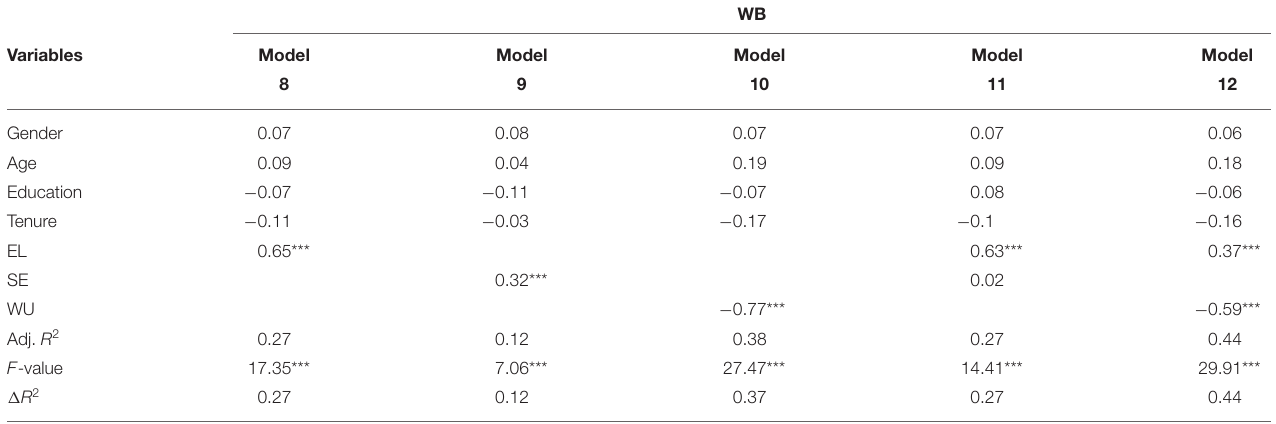
TABLE 3 | Hierarchical regression results.